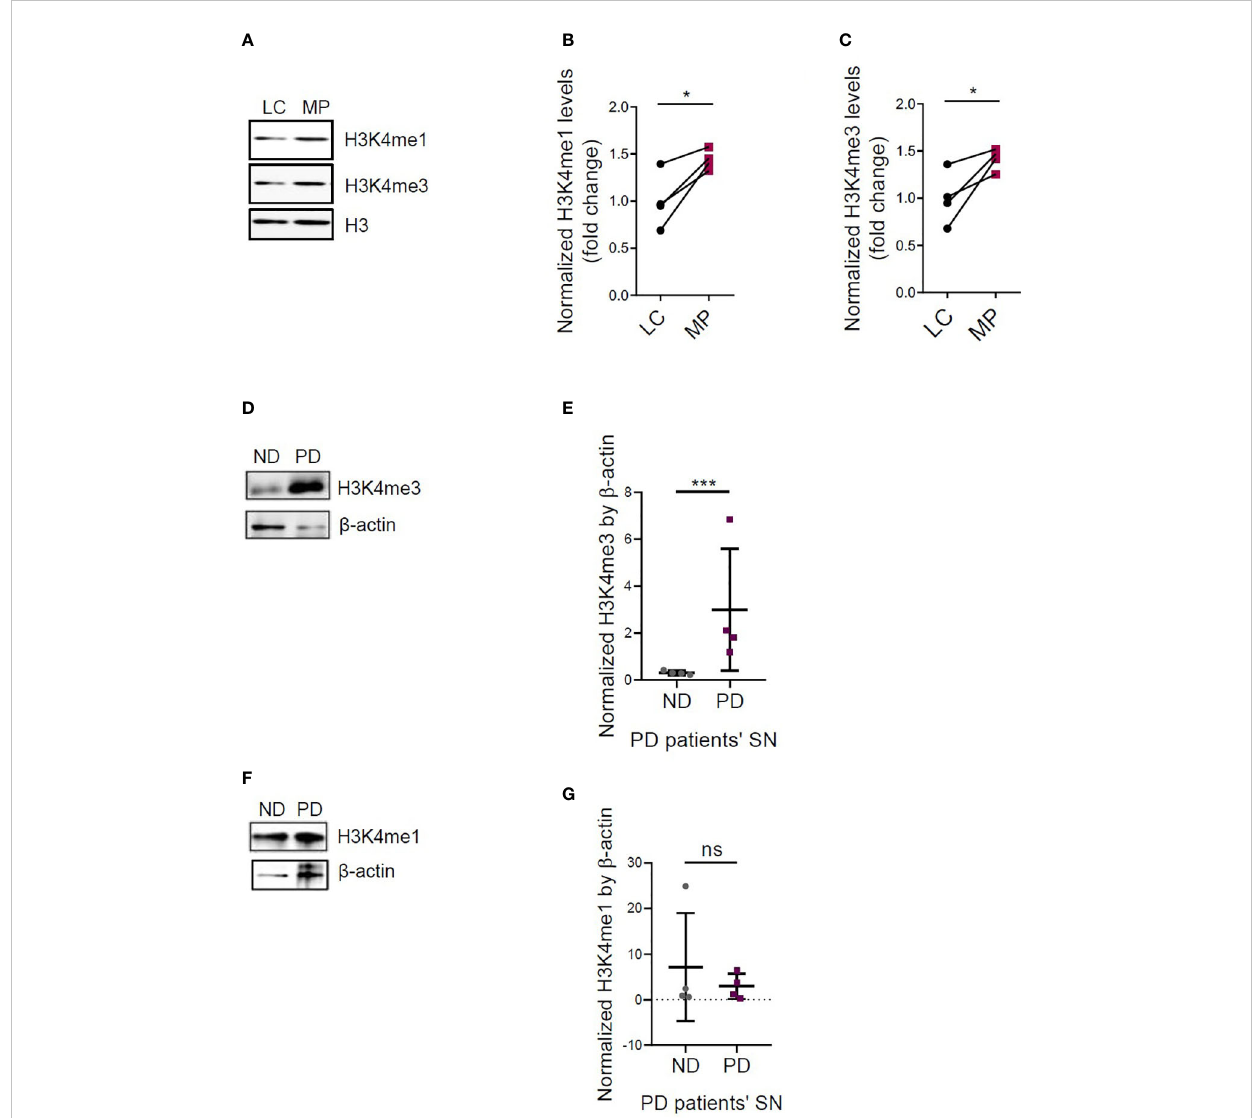
FIGURE 5 Increased H3K4me3 and H3K4me1 deposition in MitoPark mice and postmortem human PD brains. (A) Representative Western blots and (B, C) densitometry assessing H3K4me1 and H3K4me3 deposition in the substantia nigra (SN) of MitoPark mice (n=4). Representative Western blots and densitometry assessing (D, E) H3K4me3 and (F, G) H3K4me1 deposition in the SN of postmortem human PD brains (n=4). LC, littermate controls; MP, MitoParks; PD, human PD patients; ND, non-disease subjects. Data show mean±SEM of one-way ANOVA followed by Tukey ’ s post hoc test. Ctrl, control; ns, not signi fi cant; *p ≤ 0.05;